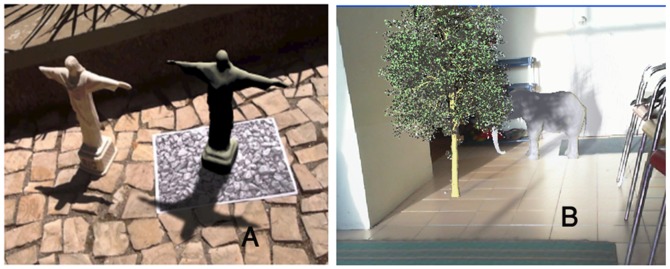
(A) Castro results [23], (B) Our results.